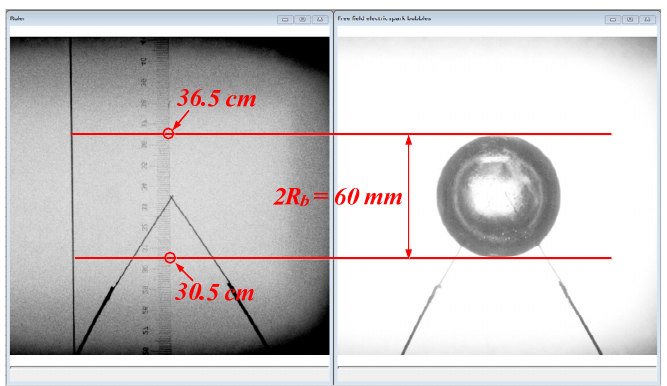
Figure 10. Schematic diagram of the method of measuring bubble diameter [11].